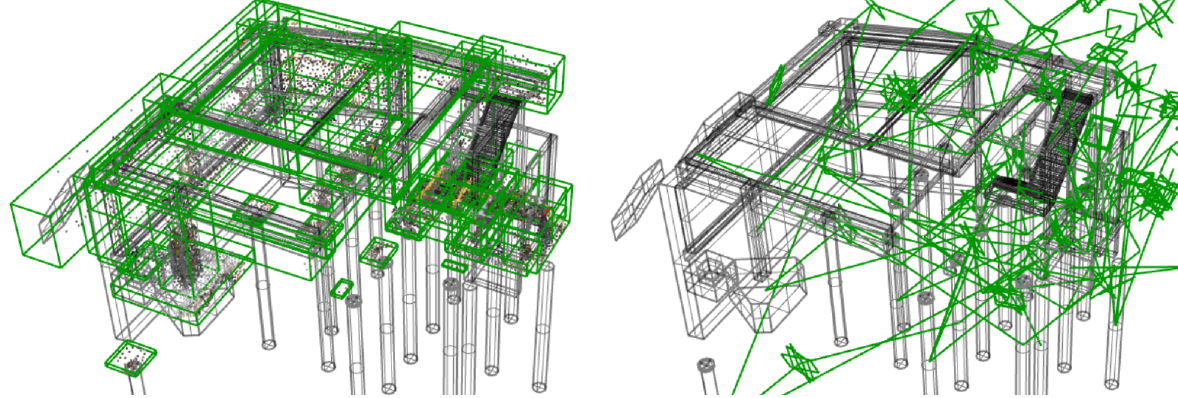
Figure 2: Overview of the remote sensing selection and segmentation